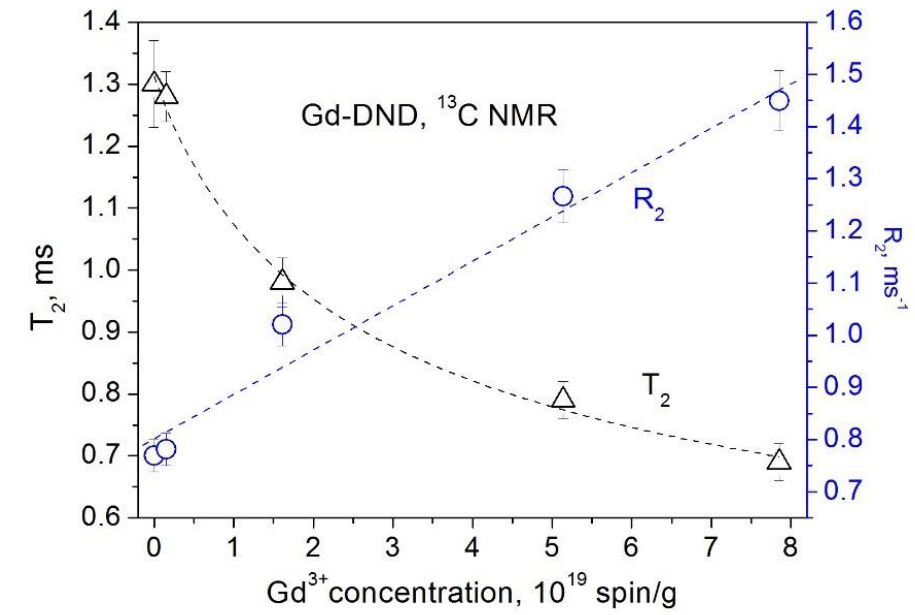
Figure 8. Dependence of the 13 C spin – spin relaxation rate R 2 (circles) and the spin – spin relaxation time T 2 (triangles) in Gd-DND powders on the Gd 3+ ion concentration.